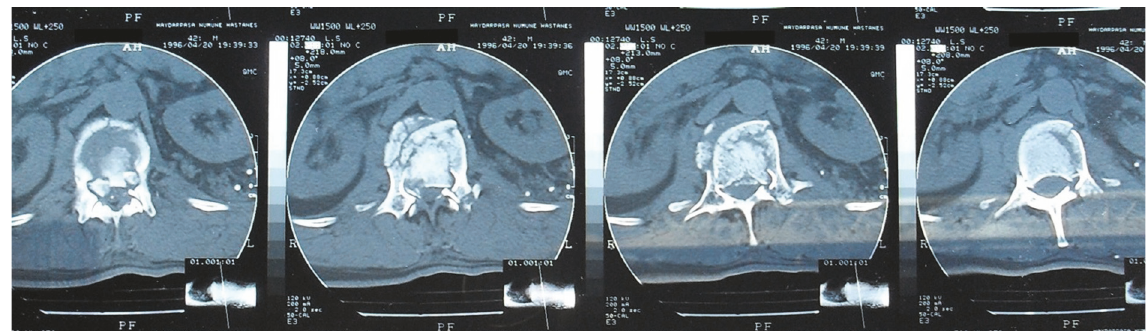
Figure 1: CT: fracture of both pedicles, left transverse process, and anterior and middle column of L1. There is absolutely no hemangioma or any other spinal soft tissue lesions at the left pedicle, left transverse process, and lamina.